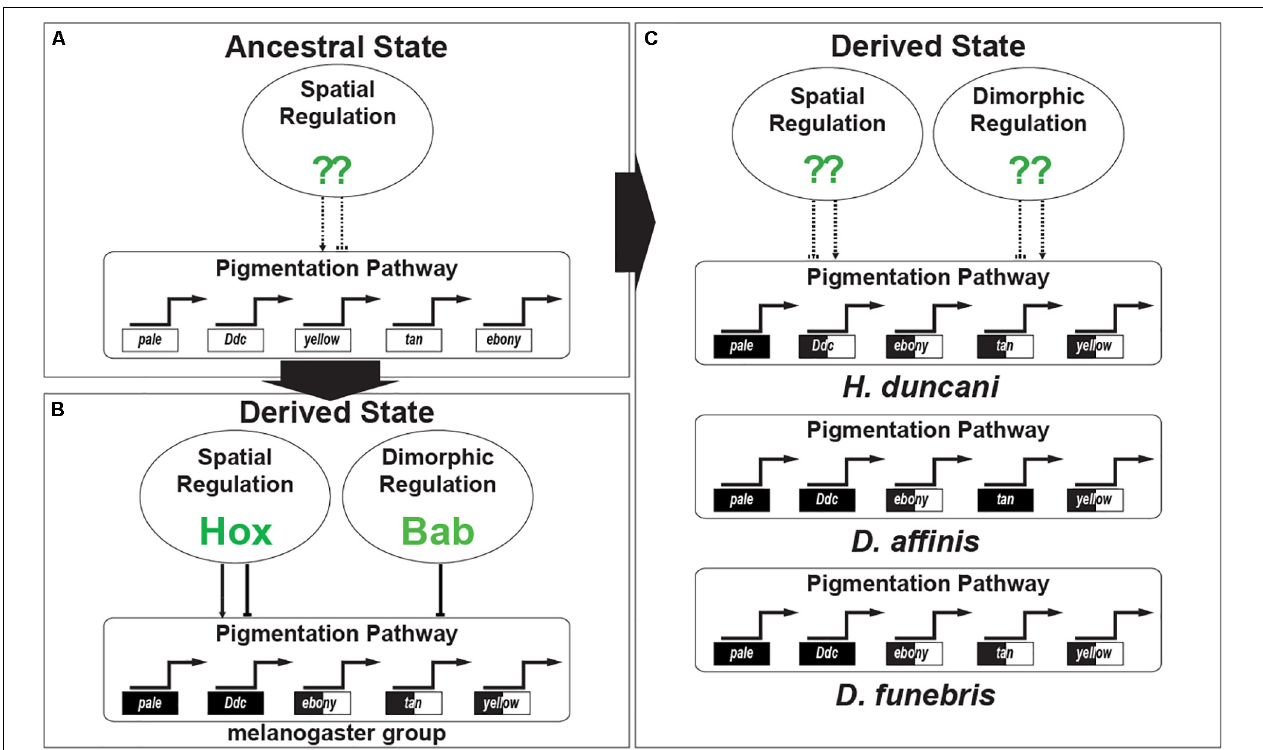
FIGURE 9 | The convergent evolution of Gene Regulatory Networks responsible for sexually dimorphic tergite pigmentation. (A) Evidence supports an interpretation where monomorphic pigmentation was ancestral among fruit flies. In such an ancestor, the GRN’s pigmentation genes were under the regulatory control of transcription factors driving spatial patterns of expression. (B) The origin of dimorphic pigmentation for the melanogaster species group involved select pigmentation genes of the GRN adopting spatial regulation by the Hox proteins Abd-A and Abd-B, and sexually dimorphic regulation imparted by the Bab proteins. (C) Convergent gains of dimorphic pigmentation involved similar patterns of pigmentation gene expression being shaped by distinct transcription factors whose identity await identification.